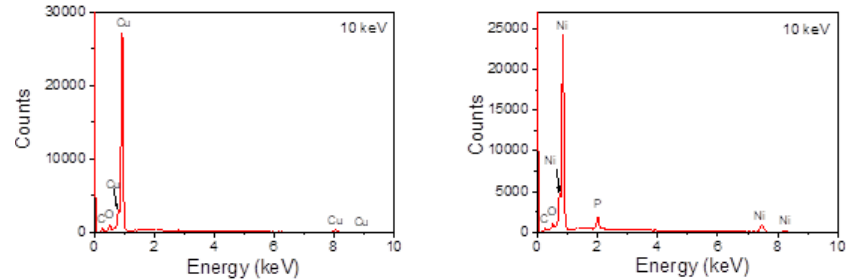
Figure 4. EDX measurements on the Cu ( left ) and Ni ( right ) layer deposited on textiles. Measure- ments are carried out at an electron beam energy of 10 keV.